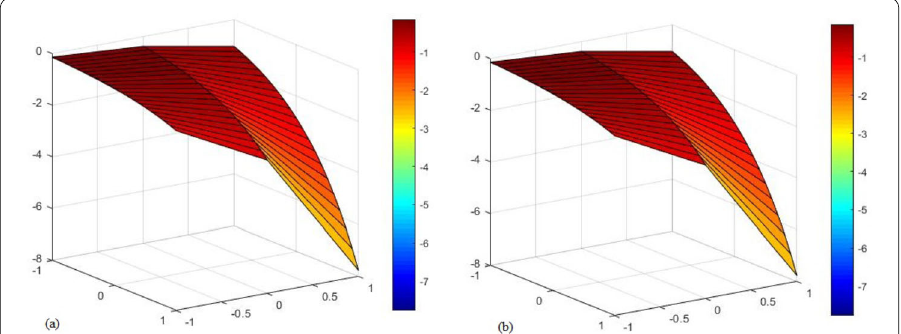
Figure 7 The graph of exact ( a ) and approximate ( b ) solution of (cid:11) ( χ , ϕ , η ) at ϒ = 1 of Example